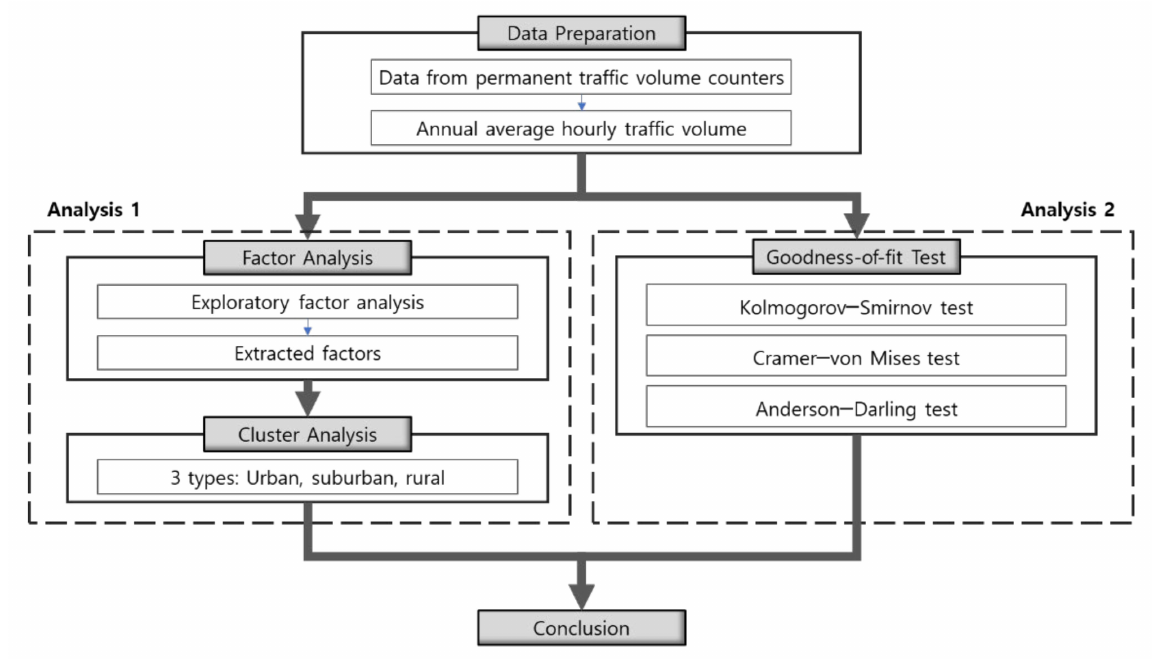
Figure 3. Flowchart of the analysis